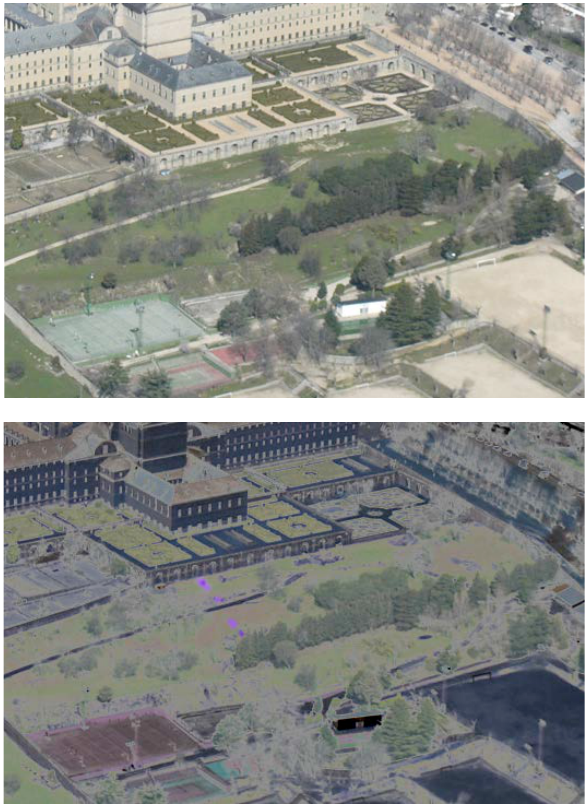
Figure 5. Comparison of the visible light spectrum and the IR images; the purple traces correspond to the main buried tunnel.